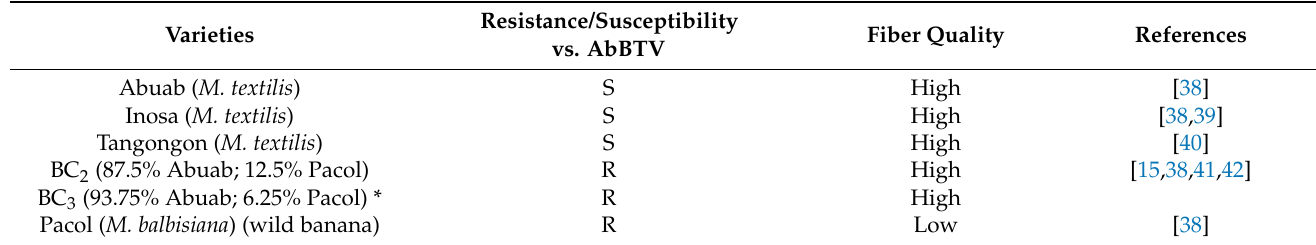
Table 2. Phenotypic performance of the six different Musa sp. varieties.